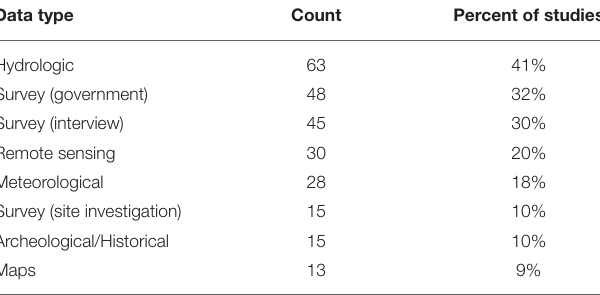
TABLE 5 | Data type used for the primary studies.